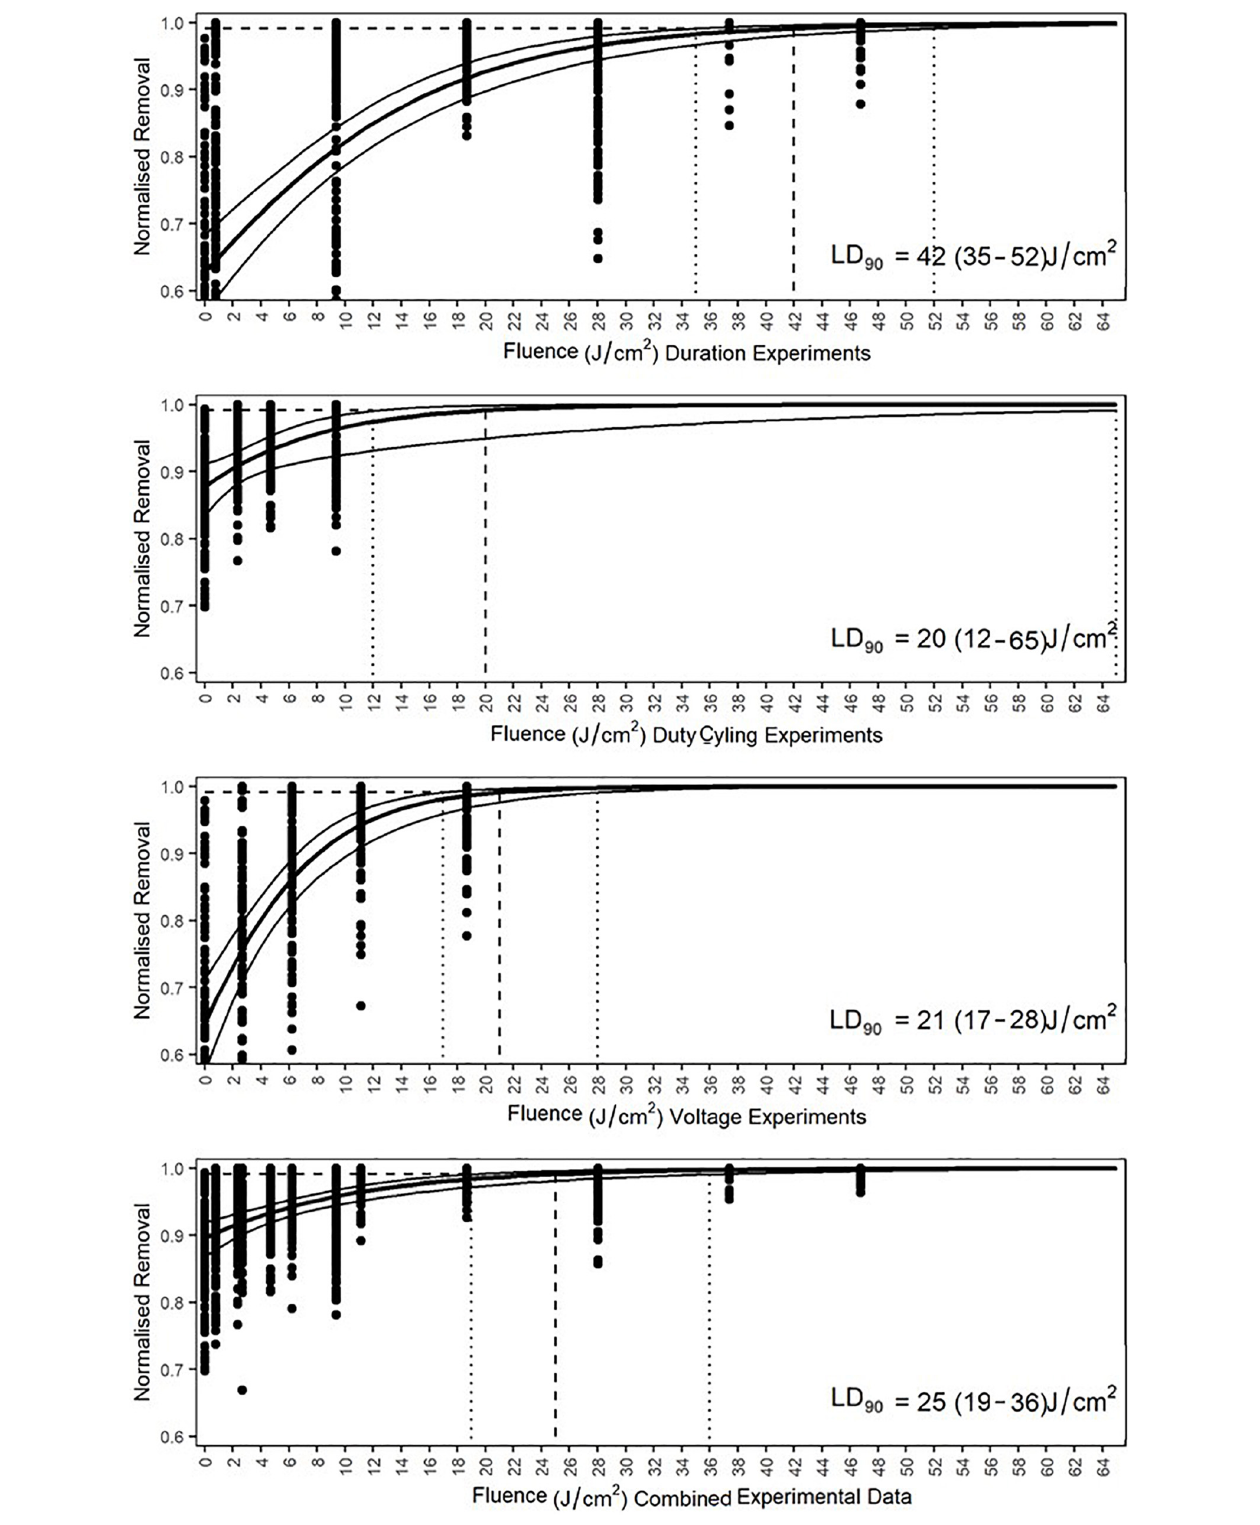
FIGURE 11 | Generalized linear model predicted lethal fluences, expressed as LD 90 , of each experiment and the combined data to obtain a 90% reduction in cell density of Navicula incerta below the initial cell density. Dashed lines intercept at the LD 90 . The 95% confidence interval ranges are indicated by the vertical dotted lines with the values in